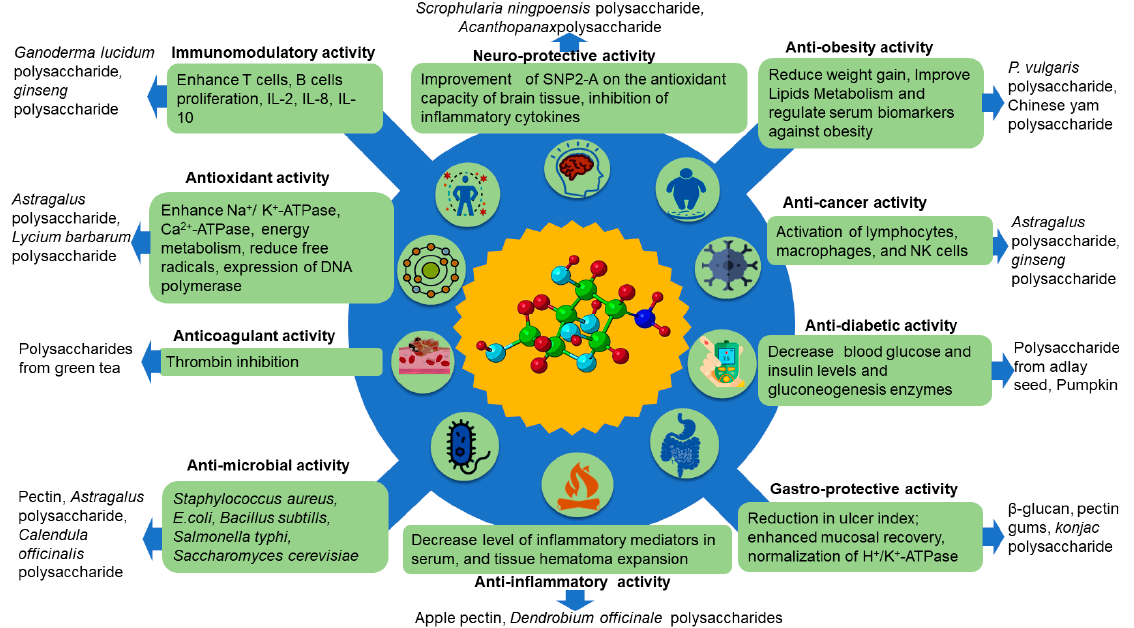
Figure 4. The bioactivities of plant polysaccharides and their influences on human health. SNP2-A, Single Nucleotide Polymorphisms; IL, Interleukins; NK cells, natural killer cells; Na ⁺ /K ⁺ -ATPase, Sodium-Potassium Adenosine Triphosphatase; Ca 2+ -ATPase, Calcium Adenosine Triphosphatase; H + /-ATPase, Hydrogen Adenosine Triphosphatase.